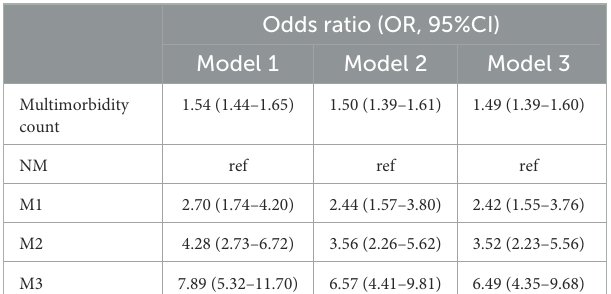
TABLE 2 Association between multimorbidity and MDs in the cross-sectional